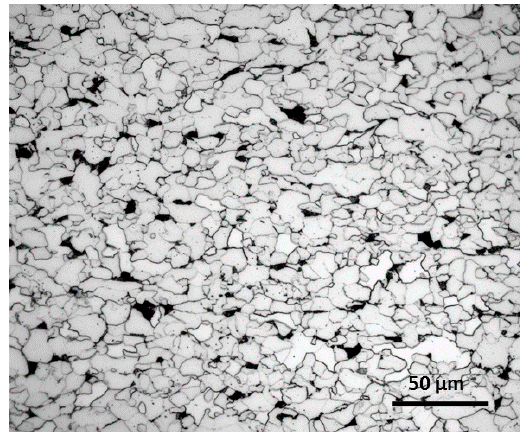
Figure 1. Microstructure of X52, typically consisting of ferrite (in white) and pearlite (in black).